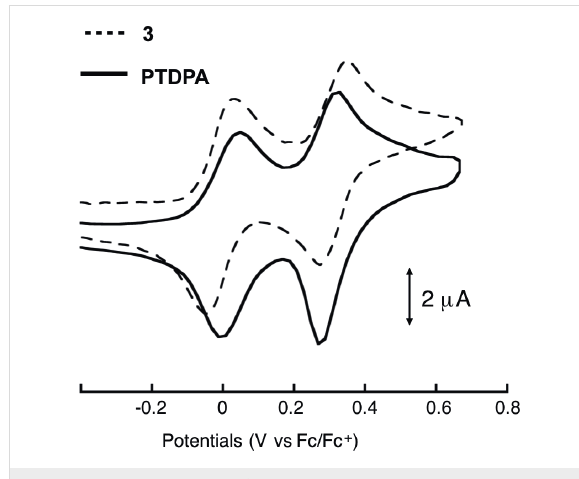
Figure 4: CV of 3 (7.8 × 10 − 4 M) and PTDPA in PhCN.